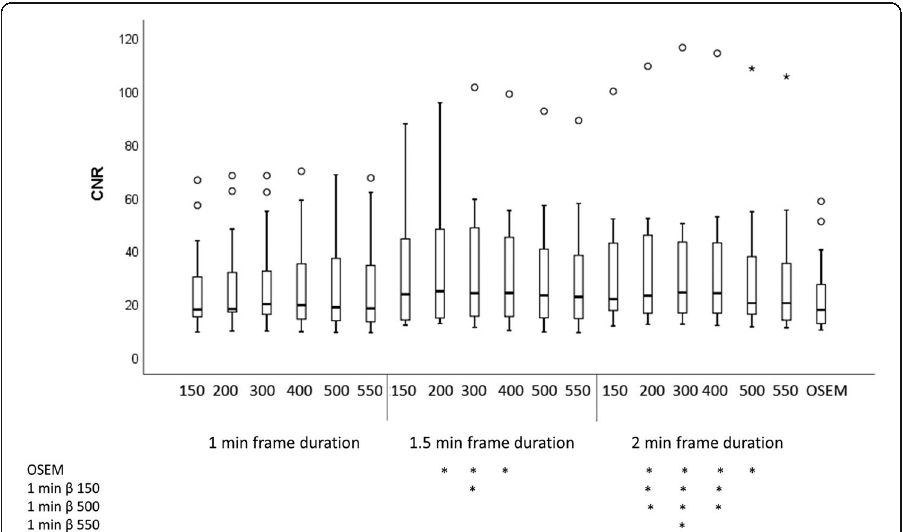
Fig. 1 Boxplot showing data for CNR in pathologic lymph nodes. The median is visible through the thick line in the middle of the boxes. The first and third quartiles are shown through the top and bottom box lines.